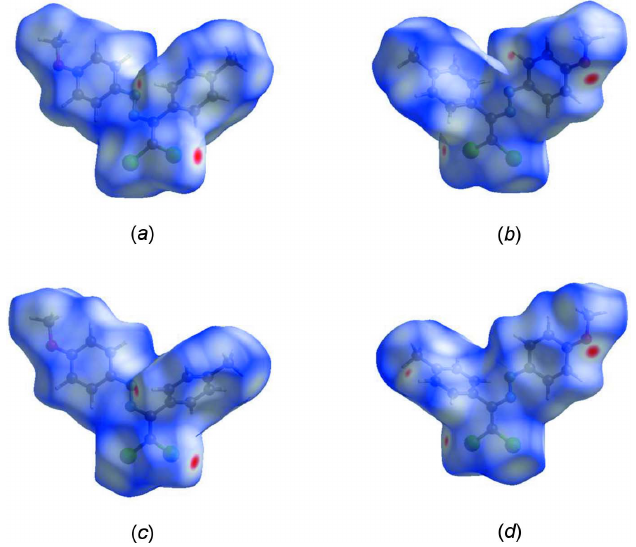
Figure 4 ( a ) Front and ( b ) back views of the Hirshfeld surface of molecule A , and ( c ) front and ( d ) back views of the Hirshfeld surface of molecule B plotted over d norm in the ranges (cid:5) 0.1125 to 1.3054 and (cid:5) 0.1000 to 1.2923 a.u., respectively, for molecules A and B